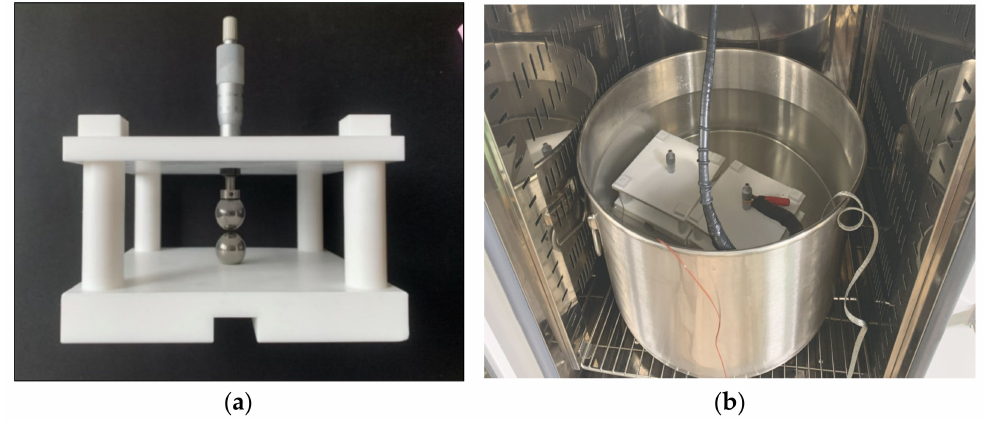
Figure 5. The pictures of V-t test: ( a ) electrode with micrometer and PTFE structure; ( b ) dummy sample inside oil for measuring temperature.